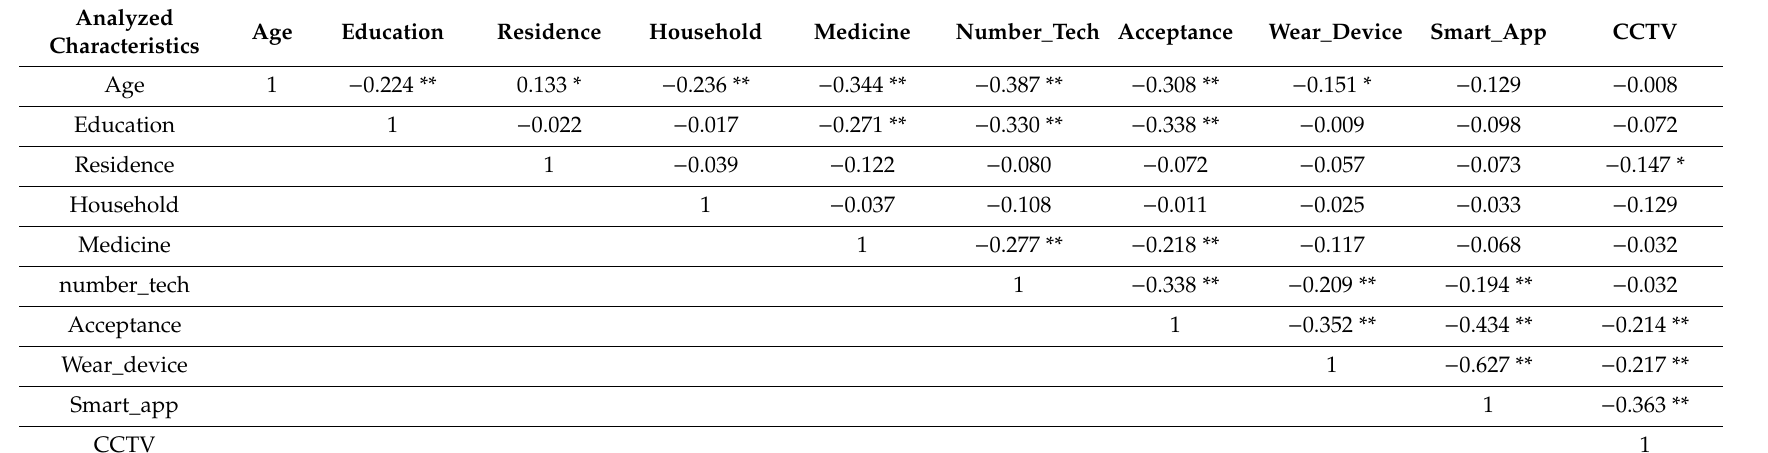
Table 7. Interesting